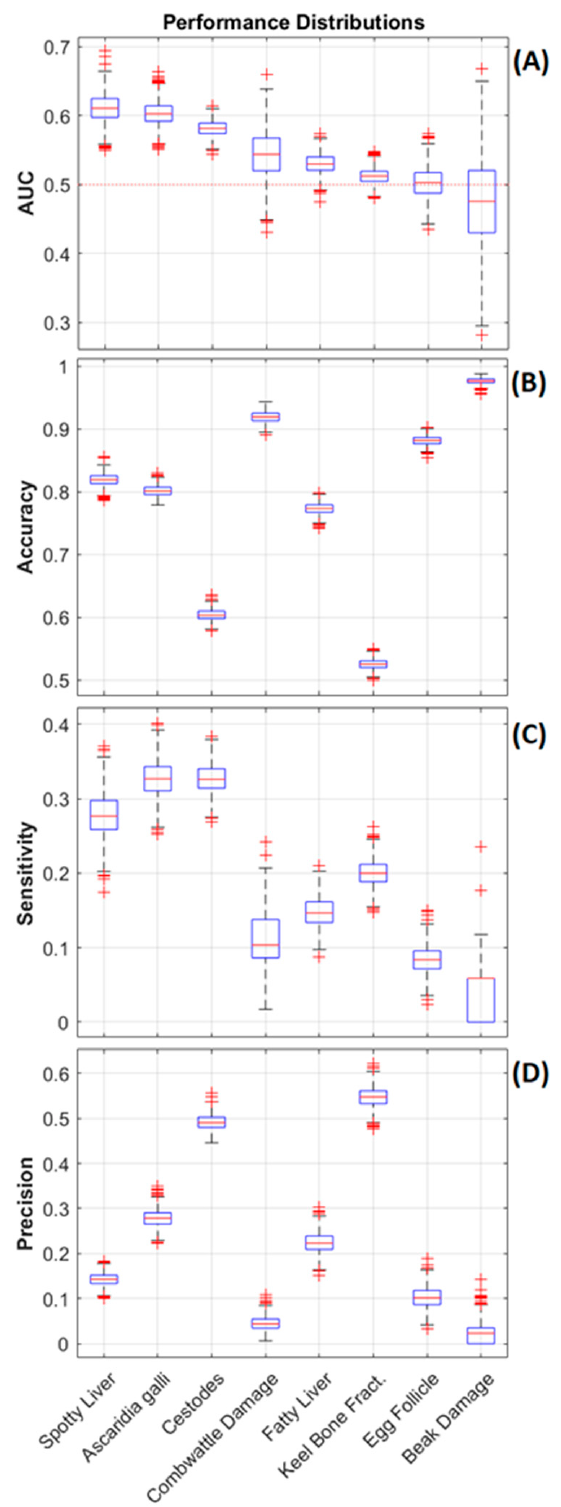
Figure 5. Performance distributions plotted as boxplots for each response variable. Part ( A ) plots the area under the ROC curve (AUC), with the red dotted line marking the performance of a random-chance classifier. Part ( B ) plots the accuracy for each model. Part ( C ) plots the sensitivity, and part ( D ) plots the precision for the minority class within each response. The responses are ordered from left to right by descending mean AUC.